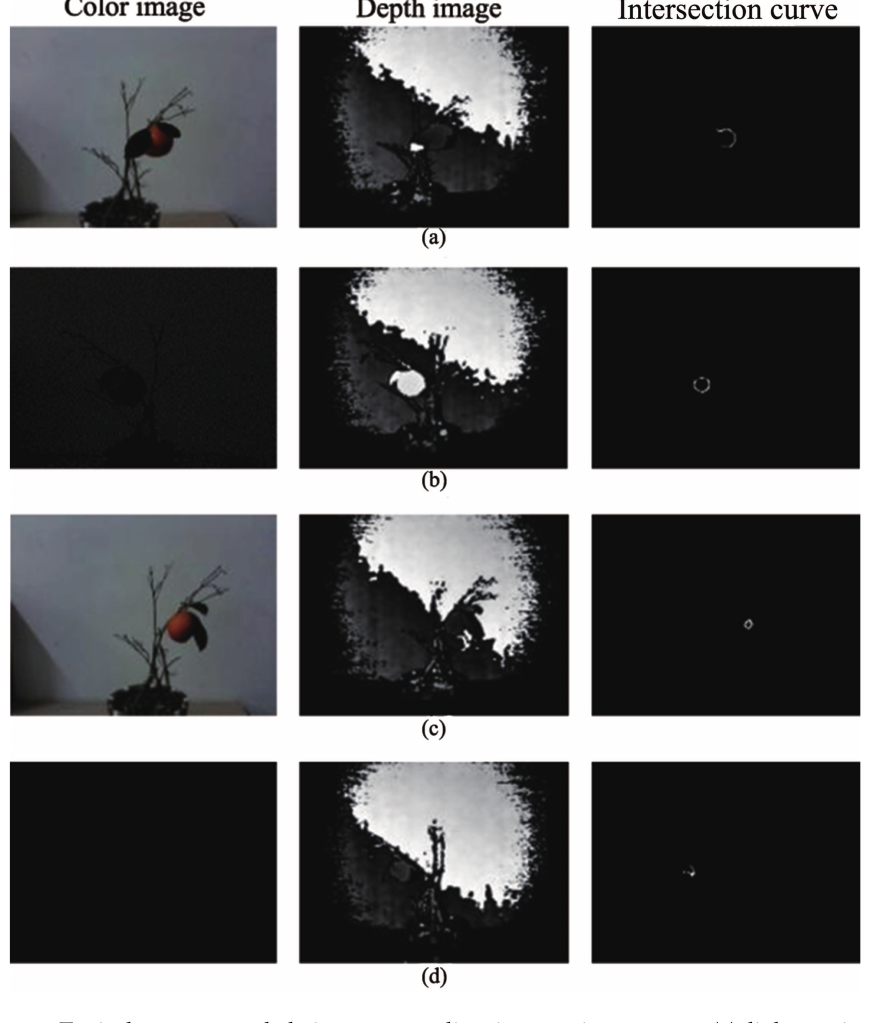
Figure 18. Typical oranges and their corresponding intersection curves: ( a ) light environment (Gannan navel orange); ( b ) dark environment (Gannan navel orange); ( c ) light environment (Sichuan ugly orange); ( d ) dark environment (Sichuan ugly